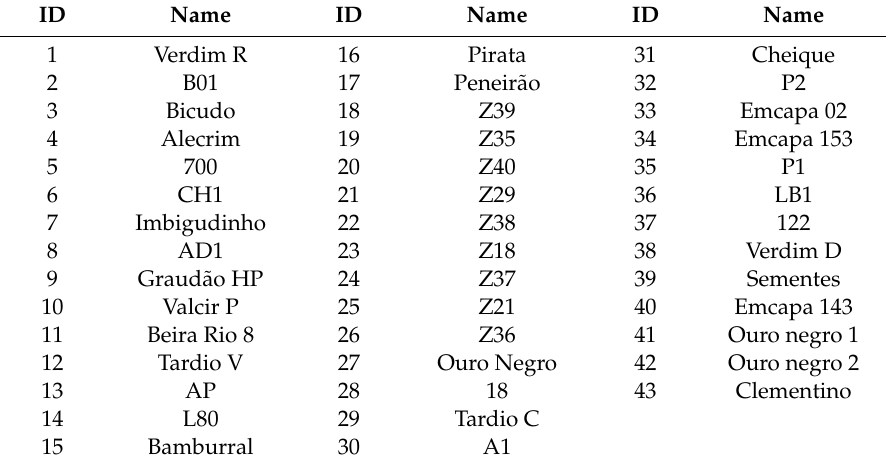
Table 2. Identification of 43 genotypes of C. canephora cultivated in Nova Ven é cia,